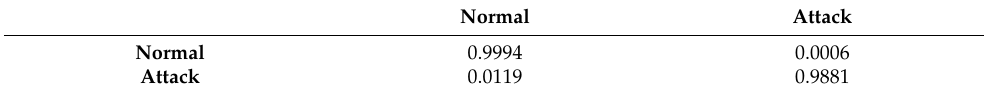
Table 9. Confusion matrix of the best model selected.